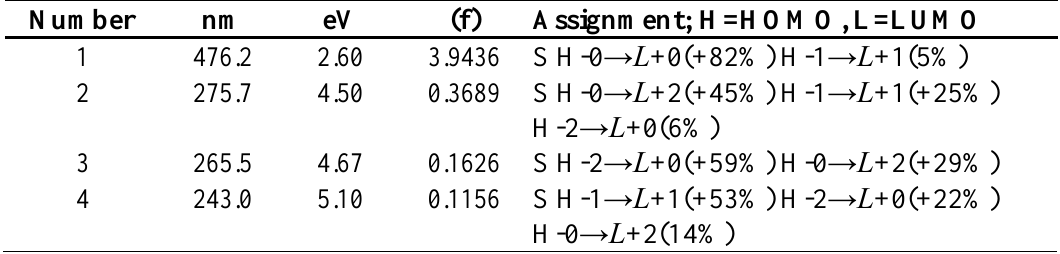
Table 4. Electronic transition states of transbixin (nm, eV, oscillator strengths (f), and transition assignments as calculated with TD-DFT and the M05-2X/6-31+G(d,p) level of theory. Only the transition states with f > 0.02 are shown.